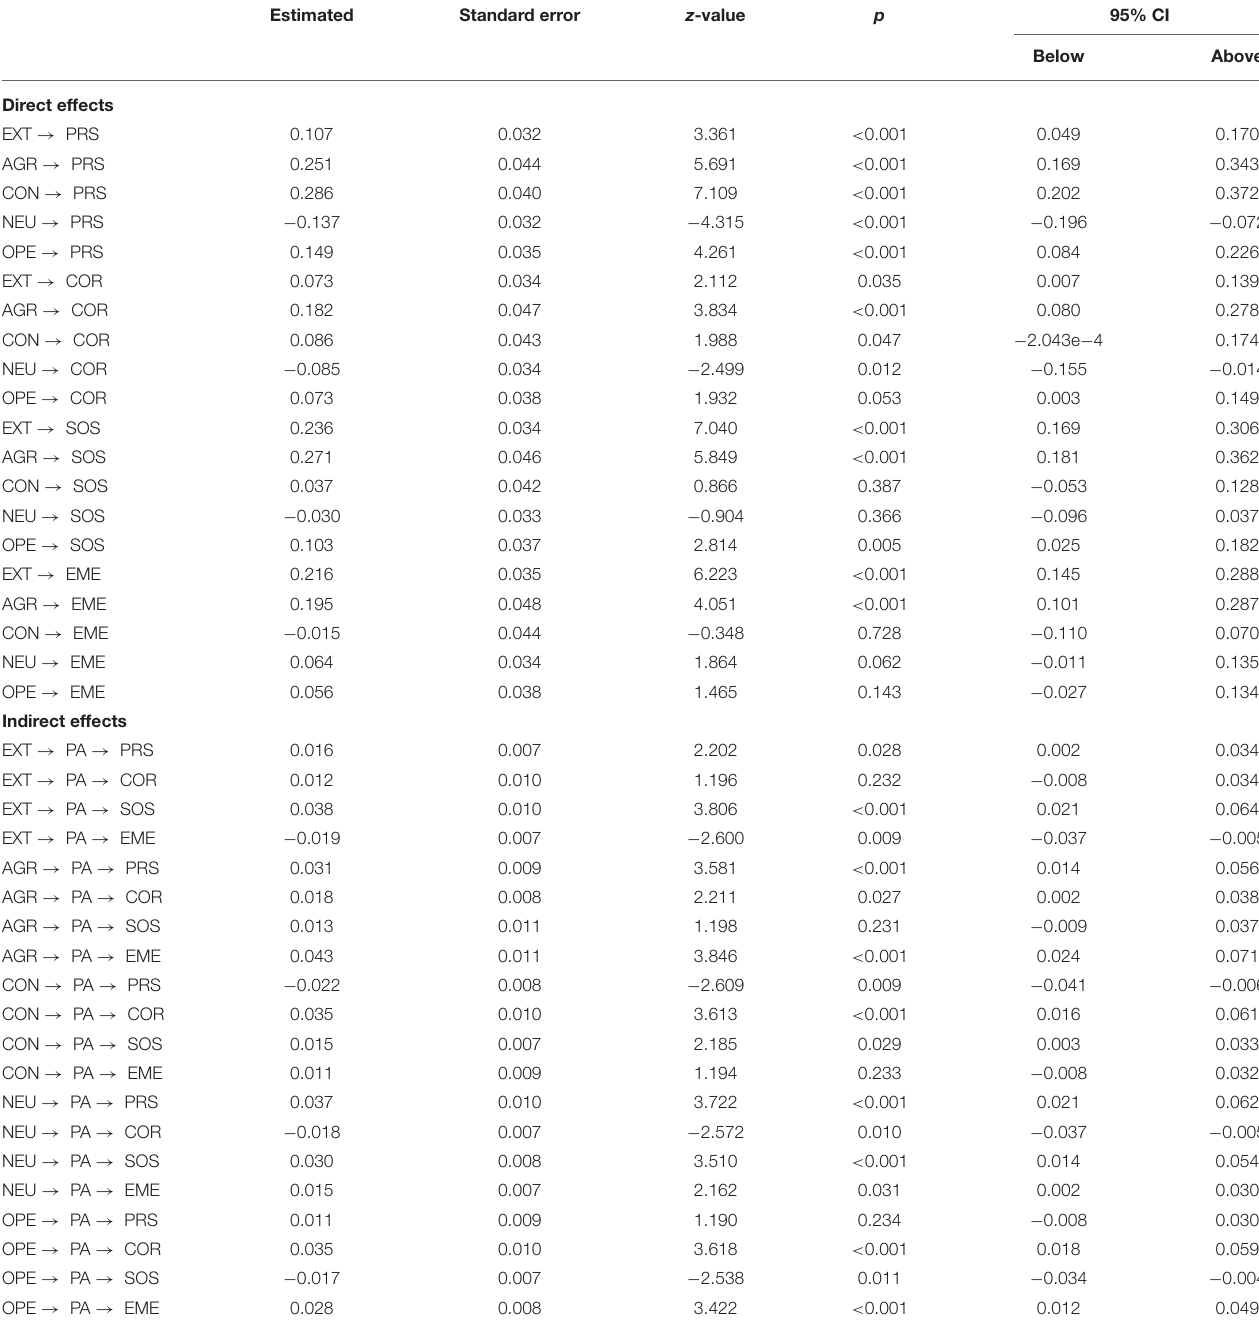
TABLE 3 | Direct and indirect effects (Model